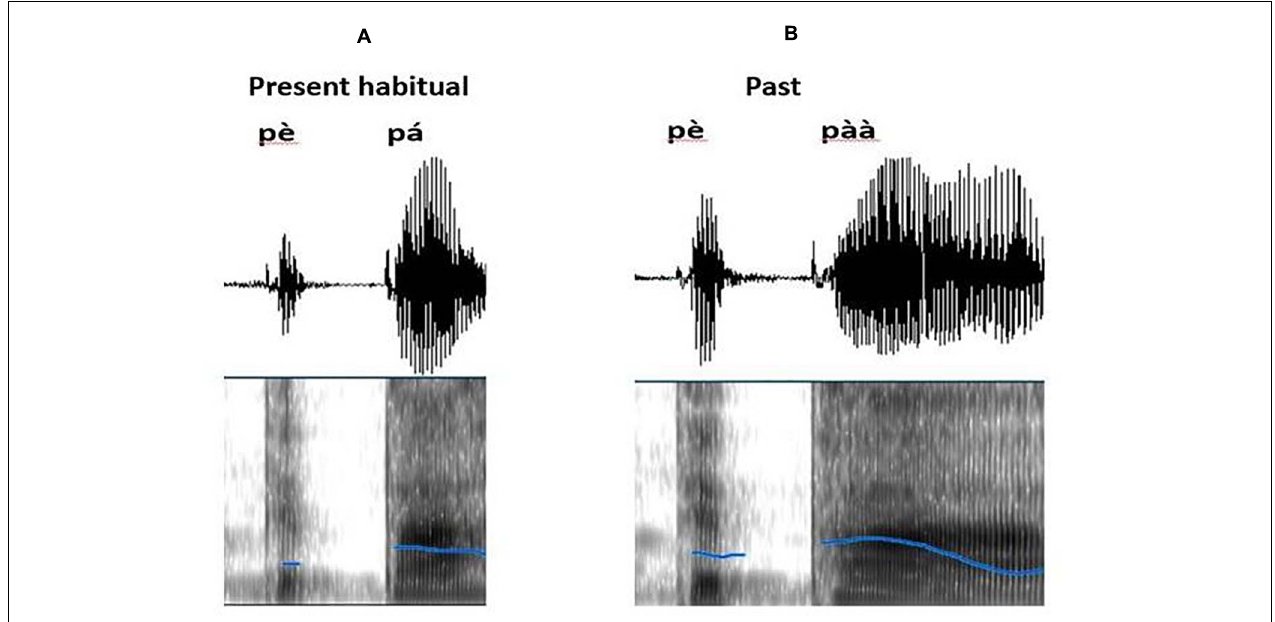
FIGURE 1 | Spectrogram showing the pitch information (blue lines) of a present habitual (A) pèpá (mops) and past (B) pèpàà (mopped) verbs.